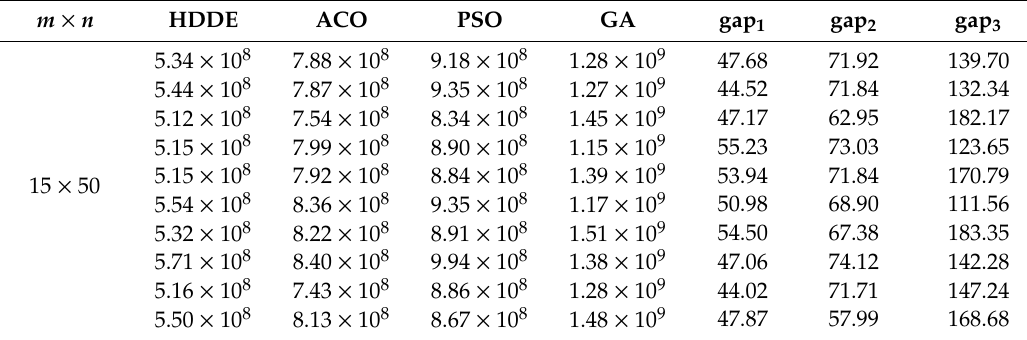
Table 11. Comparison under JSS problem